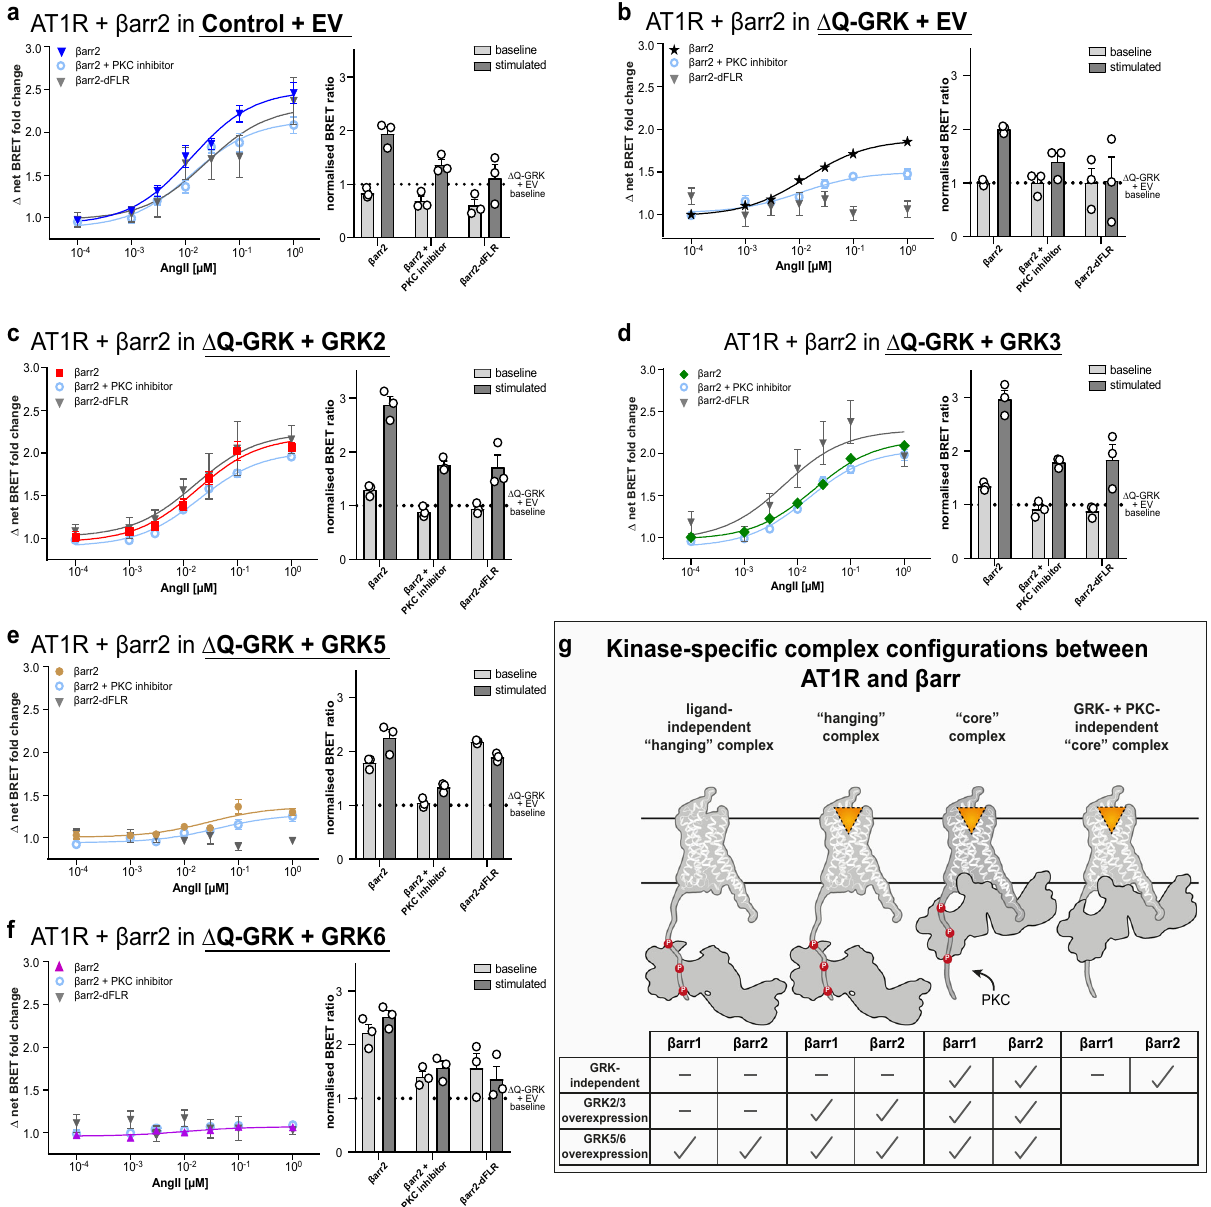
Fig. 5 Distinct AT1R – β -arrestin2 complex con fi gurations are mediated by GRK2/3, GRK5/6 or PKC. a – f To identify the contribution of the individual GRKs to the complex formation of β -arrestin2 ( β arr2) with AT1R, Control or Δ Q-GRK cells were transfected with AT1R-NanoLuc, Halo-Tag- β arr2 and either GRK2, 3, 5, 6 or the empty vector (EV) as indicated, in absence or presence of PKC inhibitor Gö6983 (500 nM). Additionally, the GRK-speci fi c β arr2 recruitment to the AT1R was measured utilising a Halo-Tag- β arr2 construct lacking the fi nger loop region (dFLR). Angiotensin II (AngII)-induced dynamic BRET changes are shown as concentration-response curves. All data points are calculated as Δ net BRET fold change normalised to baseline values and vehicle control, represented as the mean of n = 3 independent experiments ± SEM. The data are also presented in respective bar graphs, displaying the mean BRET values + SEM before (baseline) and after stimulation with 1 µ M AngII (stimulated), normalised to the basal BRET ratio derived from the corresponding Δ Q-GRK + EV condition in ( b ). The results of the statistical analysis of displayed data are listed in Supplementary Table 4. All test statistics, effect sizes, con fi dence intervals and degrees of freedom are provided in the Source Data fi les. g Schematic summary of the kinase-speci fi c complex con fi gurations between AT1R and β arr1 or 2 either in the absence of GRKs, mediated by GRK2/3 or GRK5/6 overexpression as observed in ( a – f ; Supplementary Fig.